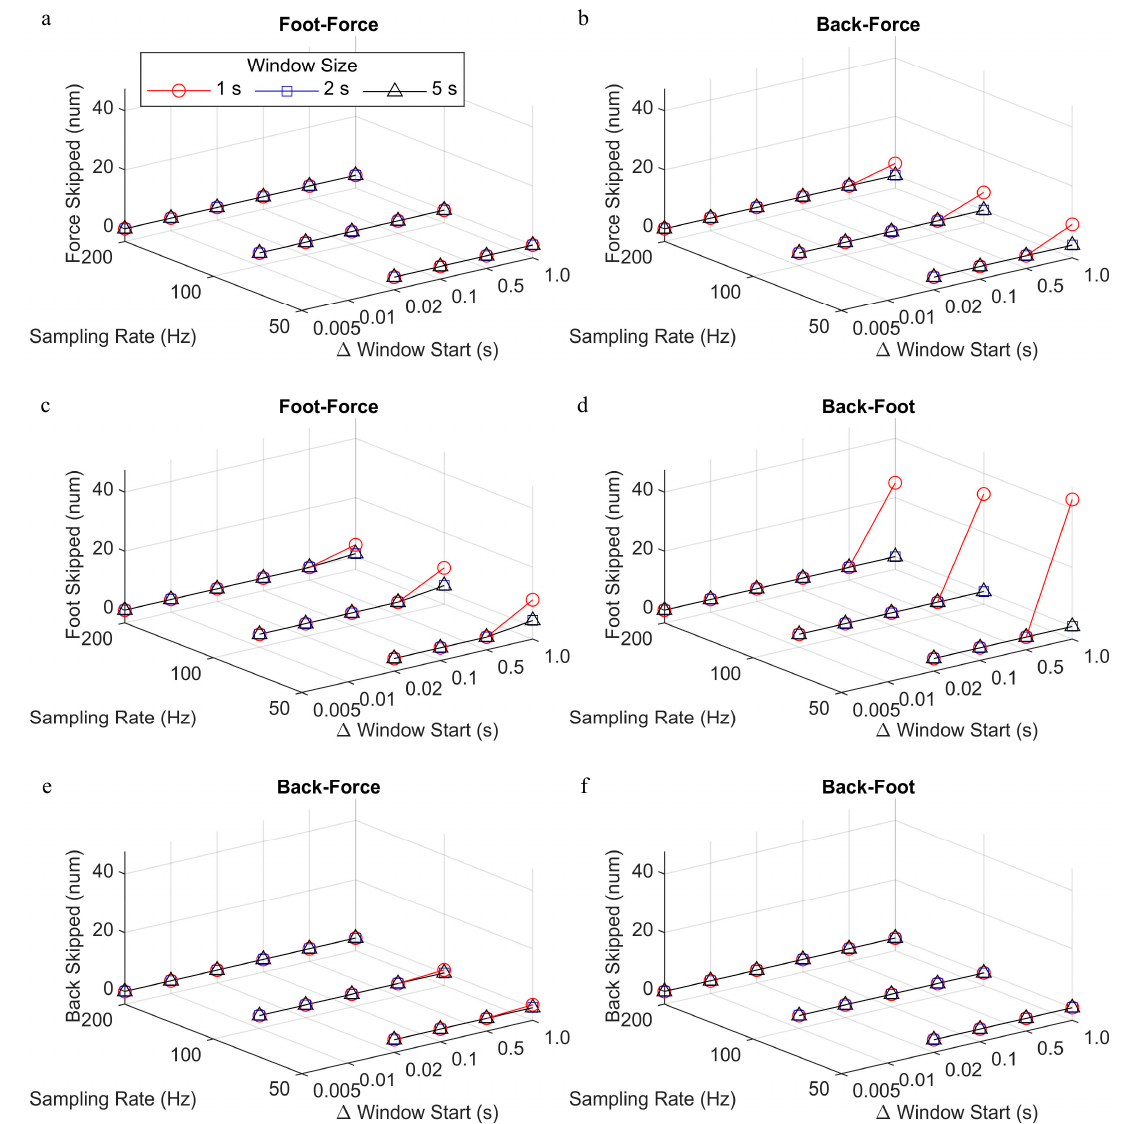
Figure 4. Number of total skipped steps (out of a mean of 1942 recorded steps) for the force (top row), foot (middle row) and back (bottom row) gait event detection methods and each comparison (foot-force, back-force, and back-foot), processed with different sampling rate, window size, and change in window start time parameters. The number of skipped steps is reported for ( a ) force method, foot-force comparison; ( b ) force method, back-force comparison; ( c ) foot method, foot-force comparison; ( d ) foot method, back-foot comparison; ( e ) back method, back-force comparison; ( f ) back method, back-foot comparison. Note, only right-side steps were compared in the foot-force and back-foot comparisons.